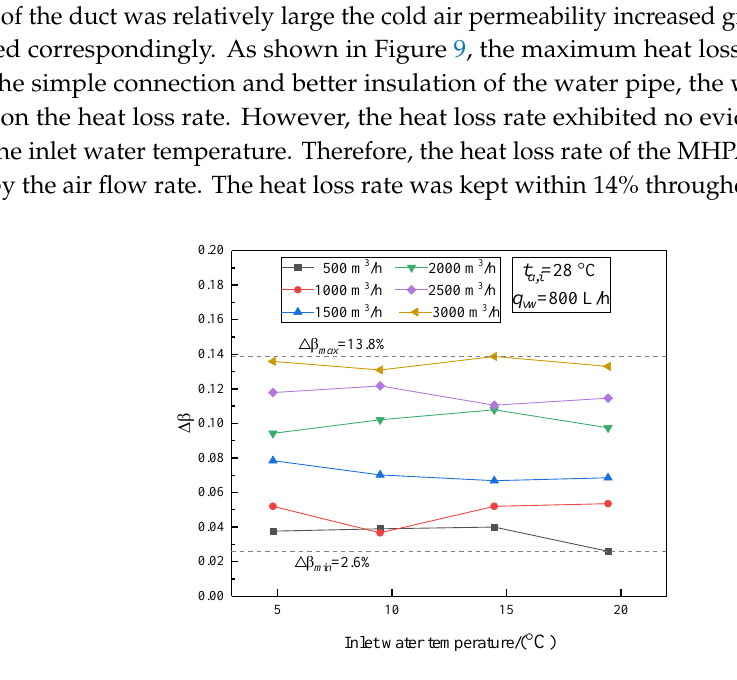
Figure 8. Variation of Δβ with inlet water temperature under different air flow rates .